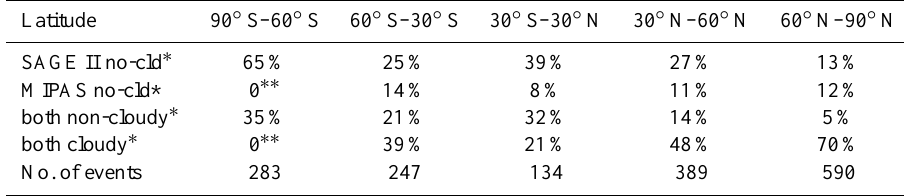
Table 4. Coincidence statistics between SAGE II and MIPAS.